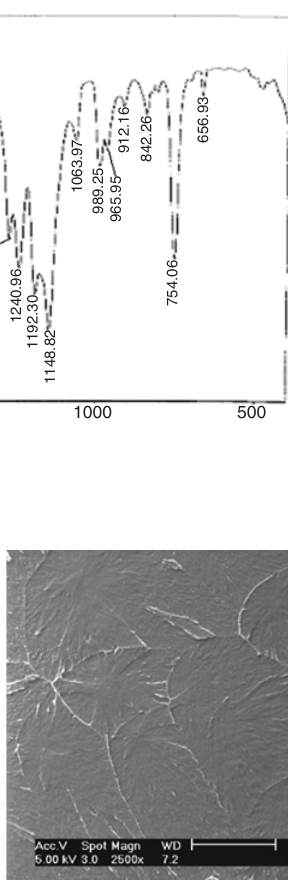
Figure 11: SEM microstructure of the sample without additive substance.